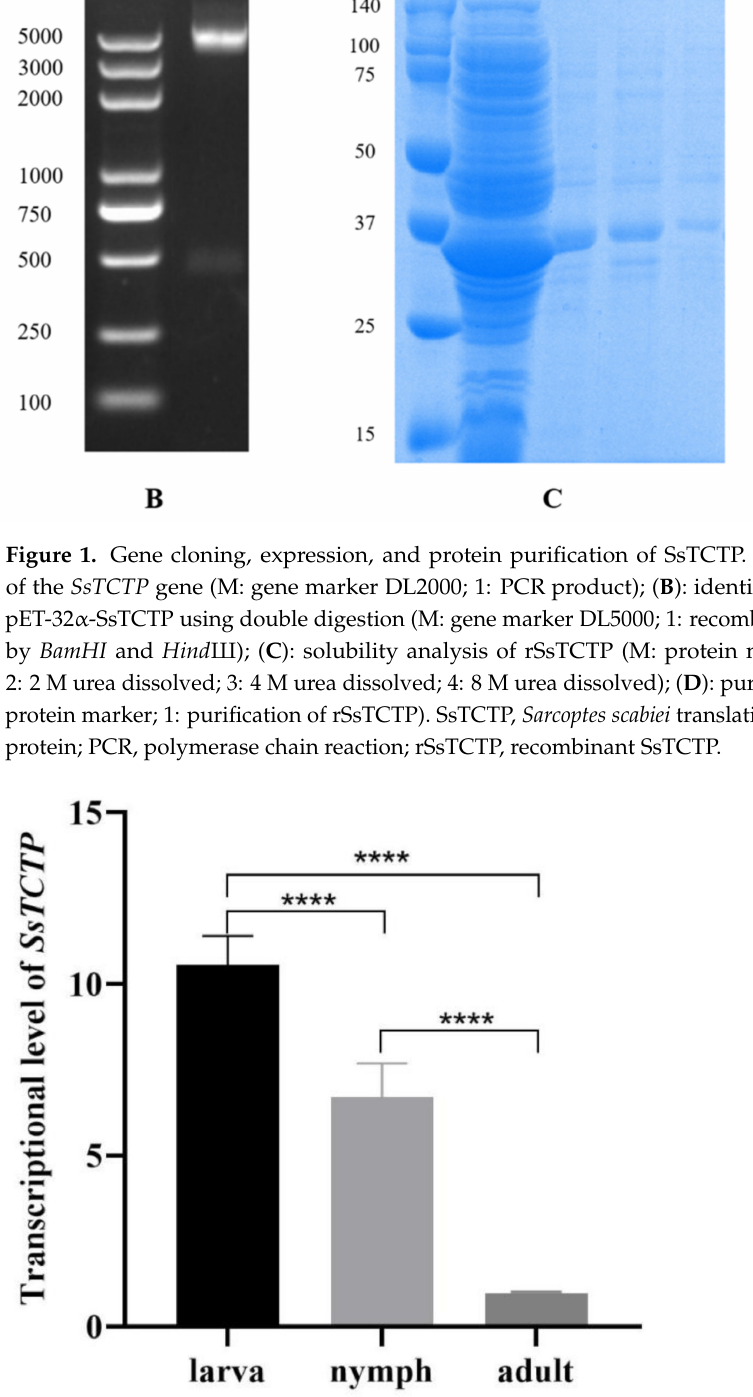
Figure 2. Transcription of the SsTCTP at larvae, nymphs, and adults. Data from three individual experiments (each experiment had three replicates) are shown as the means ± the standard deviation (SD). Statistical differences between groups were calculated using Student’s t -test (**** p < 0.0001). SsTCTP , Sarcoptes scabiei translationally controlled tumor protein